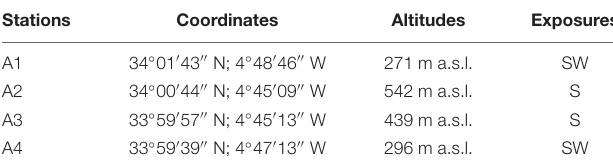
TABLE 1 | Coordinates, altitudes, and exposures of selected study